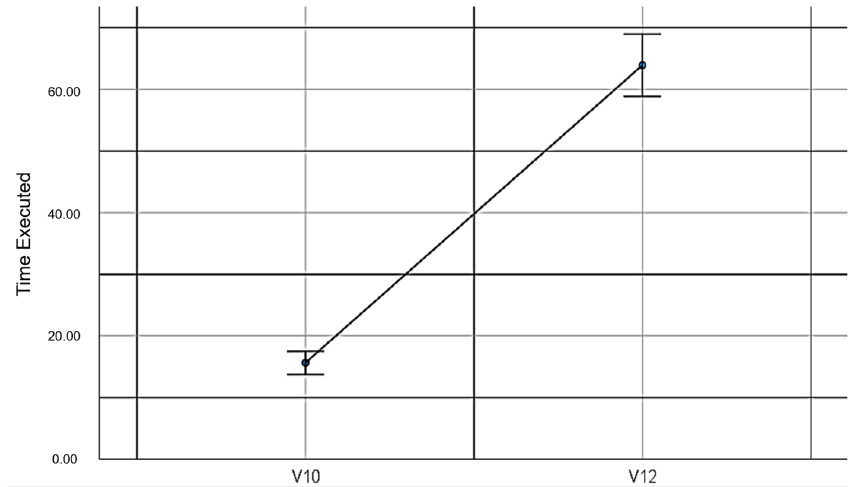
Figure 11. Execution times in the maze experiment.